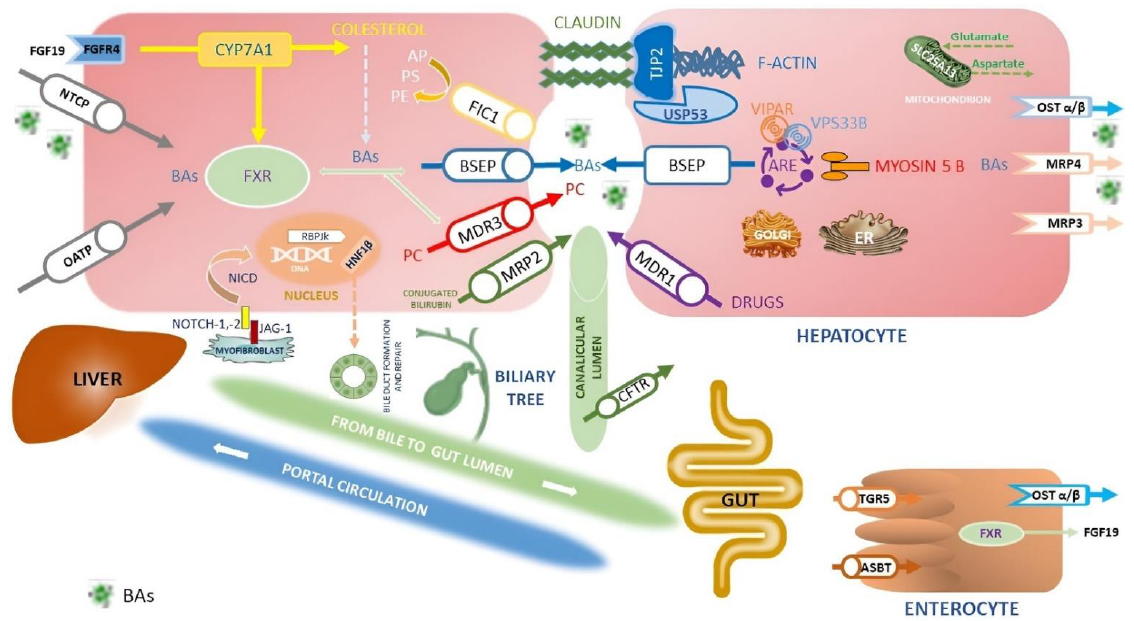
Figure 1. Simplified representation of the proteins expressed by the genes involved in cholestasis disorders and the main pathway of synthesis, transport and reuptake of BA in the liver and in the gut. Here we summarized the primary inherited cholestatic disorders in which metabolic and hepatobiliary diseases cause impaired BAs excretion. BAs are synthesized from cholesterol by CYP7A1 and then transported into canaliculi through the BSEP (PFIC2). Liver storage of BAs leads to liver injury, itching and increased risk of HBCs. Other constituents of bile include PC, transported by canalicular MDR3 (PFIC3), and PS, shuttled by canalicular ATP8B1 (PFIC1). Between disorders of membrane transporter or polarity, there is Dubin Johnson syndrome, where mutations in ABCC2 cause defects in MRP2, organic anions and bilirubin glucuronide transporter. Instead, ATP8B1 encodes MDR1 that translocates drugs and phospholipids across the hepatocyte membrane; it is responsible for developing resistance to anticancer drugs. The TJP2 (PFIC4), Claudine (neonatal ichthyosis sclerosing cholangitis), and USP53 (PFIC8) proteins are necessary to maintain the canalicular membrane polarity of hepatocytes and inhibit the reflux of BAs back into the cell: disorders of cytoskeletal and tight junction proteins cause cholestasis. The primary regulator of BAs metabolism is FXR (PFIC5): FXR inhibits CYP7A1 expression, stimulates the synthesis of FGF-19 to inhibit CYP7A1 expression through the FGFR4 pathway in the hepatocytes, stimulates BSEP to export of BAs, downregulates NTCP repressing the uptake of BAs by the liver, finally increases the expression of OST- α / β involved in BAs excretion from the liver to the portal vein and in intestinal reuptake. MYO5B, responsible for a form of PFIC and microvillous inclusion disease, interacts with RAB11A, altering the targeting of BSEP to the canalicular membrane via ARE; mutations in genes encoding RE-associated proteins such as MYO5B, VPS33B, and VIPAR (arthrogryposis, renal dysfunction and cholestasis syndrome— ARC) highlights the role of the RE in establishment and maintenance of hepatocyte polarity. BAs are carried into the hepatocyte by NTCP, OST- α , and OST- β on the basolateral membrane. Instead, ASBT on the ileal enterocyte reabsorbs approximately 95% of BAs, which enter the portal circulation via enterocyte transporters OST- α , OST- β , and MRP3. Mutations in SLC51A encoding the OST α -OST β proteins cause PFIC6. Together with FXR, TGR5 is a primary BAS-sensing receptor involved in the interaction between BAs and microbiota; it is a negative regulator of the HCC envelope through its anti-inflammatory properties and abilities to guarantee correct homeostasis of BAs. SLC25A13 gene encodes the calcium-binding protein citrin, an aspartate–glutamate carrier sited within the inner mitochondrial membrane. Citrin plays a crucial role in protein, nucleotide, and urea synthesis in several metabolic pathways. Mutations in SLC25A13 lead to neonatal intrahepatic cholestasis caused by citrin deficiency (NICCD) and increased susceptibility to HBCs. Cell–cell Jagged/Notch interactions are critical for the differentiation of cells in the early phases of development. The ligand–receptor link induces proteolytic cleavage of the Notch receptor and release of the NICD. The NICD translocates into the nucleus where it activates RBPJ κ , thus promoting Notch target genes’ transcription, including HNF1B